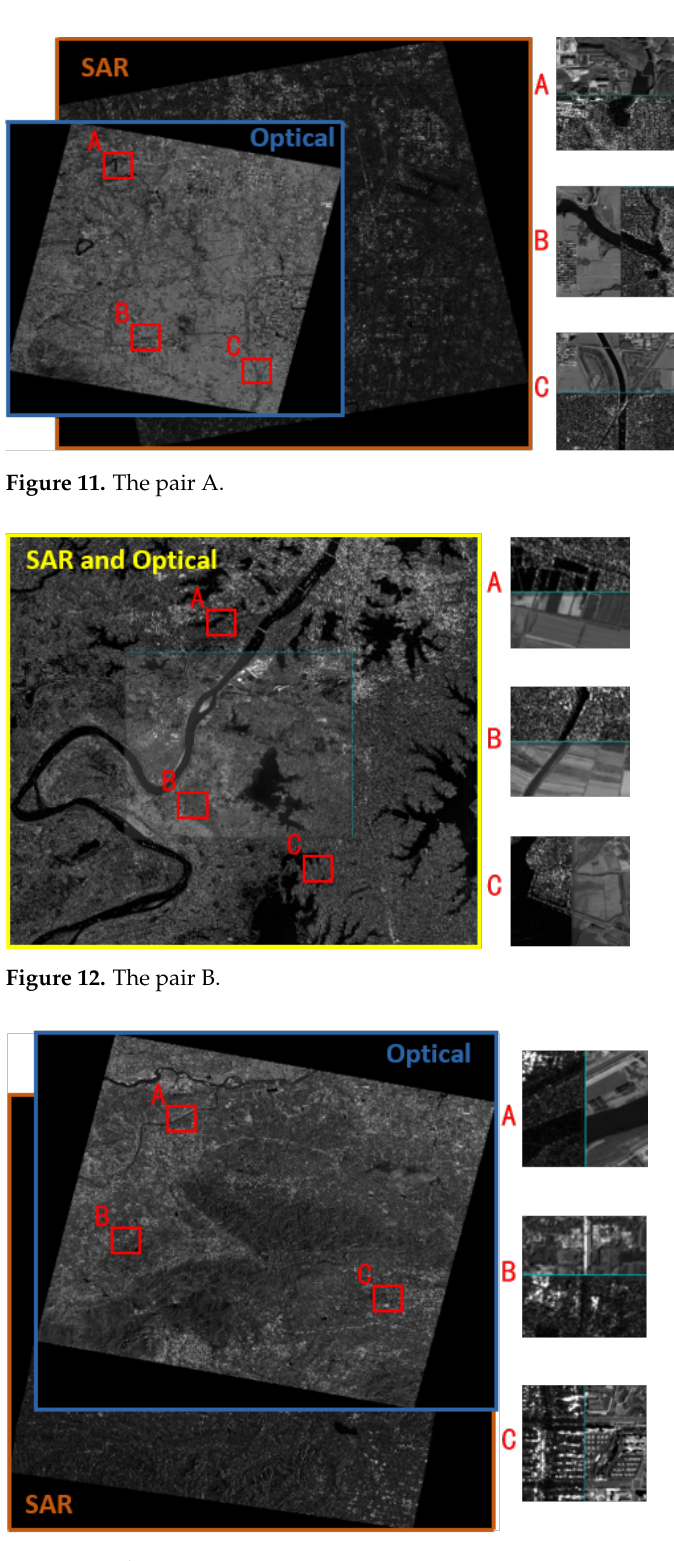
Figure 13. The pair